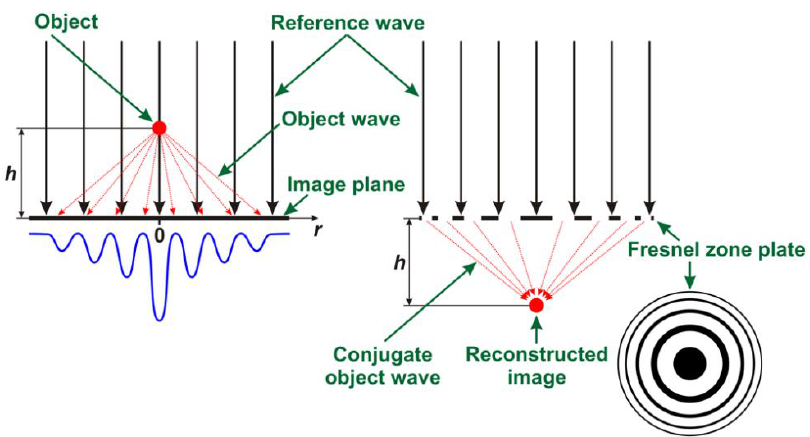
Figure 2. Simple optical hologram of a point target.